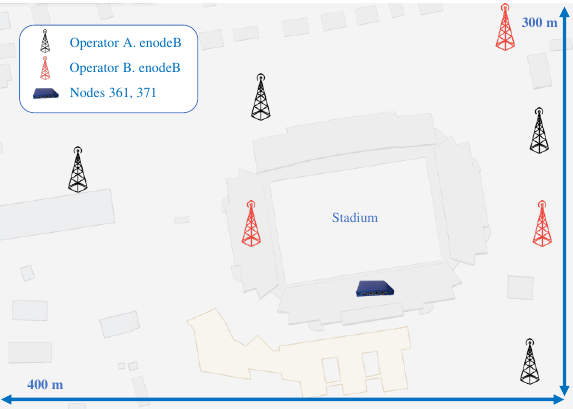
Figure 2. Approximate locations [41] of network elements in the stadium